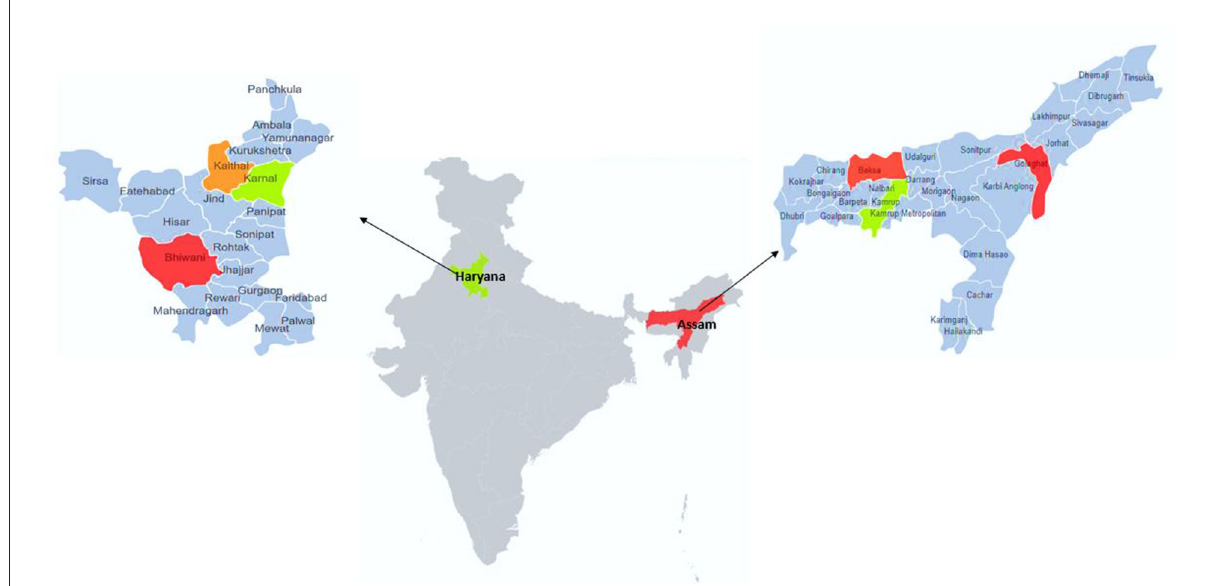
FIGURE1 Map of India showing the Haryana and Assam states, with the three districts within each state included in a study on knowledge on food safety and antimicrobial resistance among milk vendors.